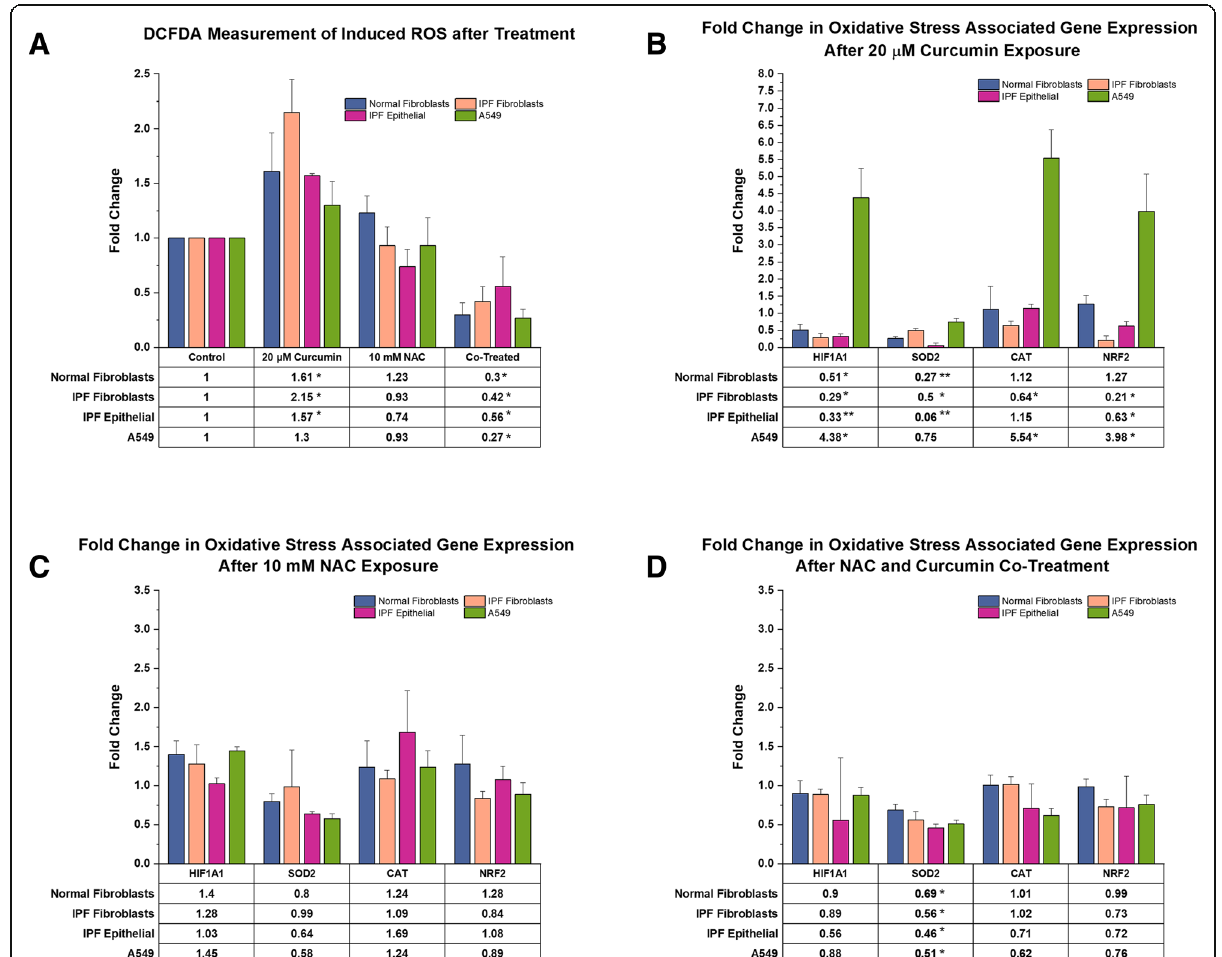
Fig. 6 Induction of ROS and change in Oxidative Stress Associated gene expression after 24-h challenge in both epithelial and fibroblast cell lines: ( a ) 20 μ M curcumin induces significant increases in ROS generation in all primary cell lines (IPF-F n=3, NHLF n=3, IPF-E n=3), but no significant increase in A549 cells (n=3). 10mM NAC treatment has no significant induction of ROS, however co-treatment with 10mM NAC and 40 μ M curcumin results in a significant decrease in ROS in all cell types. ( b ) Challenge with 20 μ M curcumin results in a decreased expression of Hypoxia inducible factor 1 α (HIF1) and Superoxide Dismutase 2 (SOD2) in IPF-F (n=4), NHLF (n=3), IPF-E ( n =3). Expression of Catalase (CAT) is decreased in IPF derived fibroblasts while Nuclear Factor erythroid 2-related factor 2 (NRF2) expression is decreased in IPF-F and epithelial cells. A549 cells demonstrate an increase in expression of HIF1, CAT, and NRF2 after challenge with 20 μ M curcumin. ( c ) 10mM NAC challenge results in a significant decrease in SOD2 expression in primary IPF epithelial cells and A549s but no effect on any other gene in the assayed cells. (D) Co-treatment with 10mM NAC and 40 μ M curcumin induces decreased SOD2 expression in all cell types. * indicates p value <0.05 and ** indicates p value